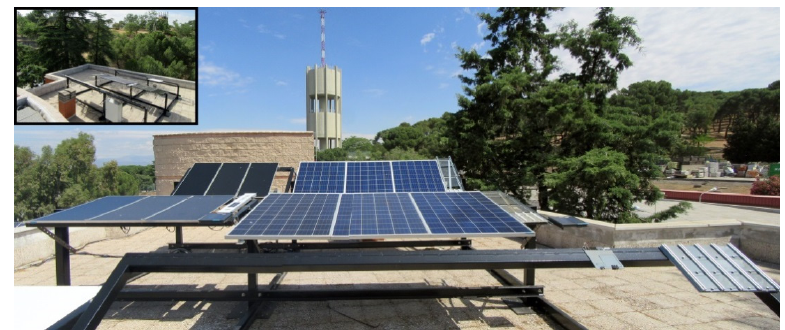
Figure 4. Panoramic view of the rooftop PV system installed for soiling monitoring.